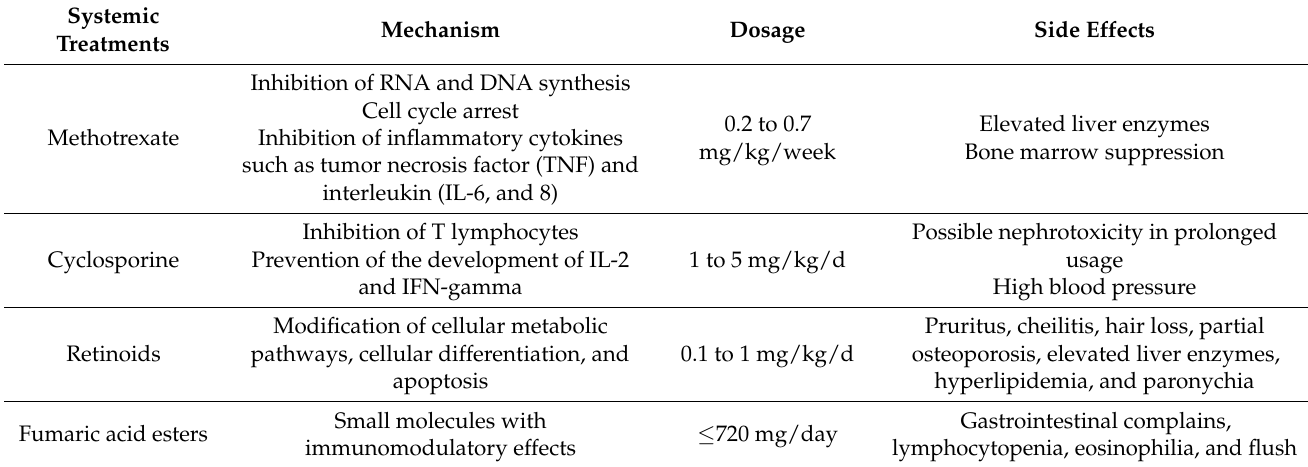
Table 1. Systemic treatments for pediatric